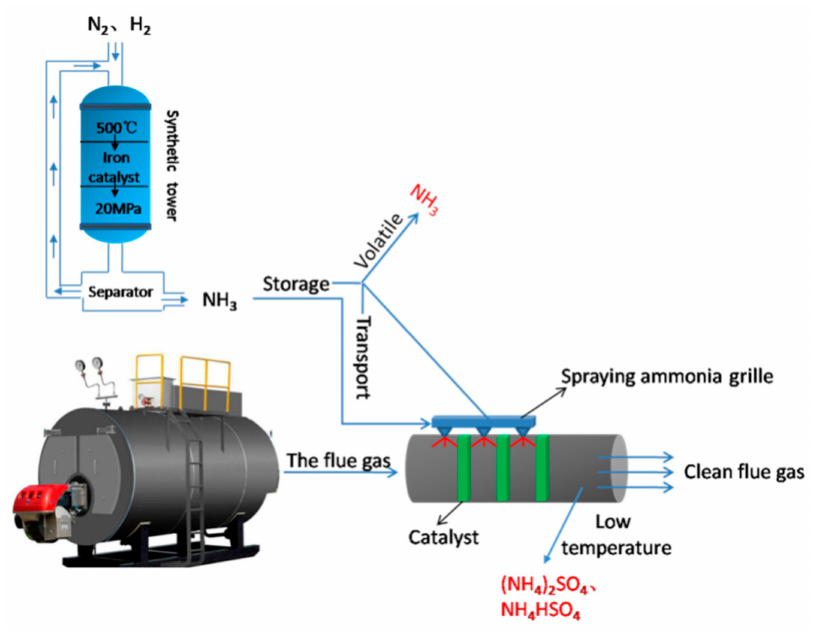
Figure 1. A schematic process of NH 3 -SCR of NO x